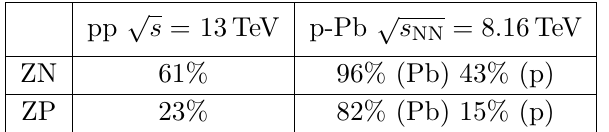
Table 1 . ZN and ZP event selection fractions (see text for details) in pp and p-Pb collisions. For the p-Pb colliding system, both the Pb-fragmentation (Pb) and the p-fragmentation (p) sides are